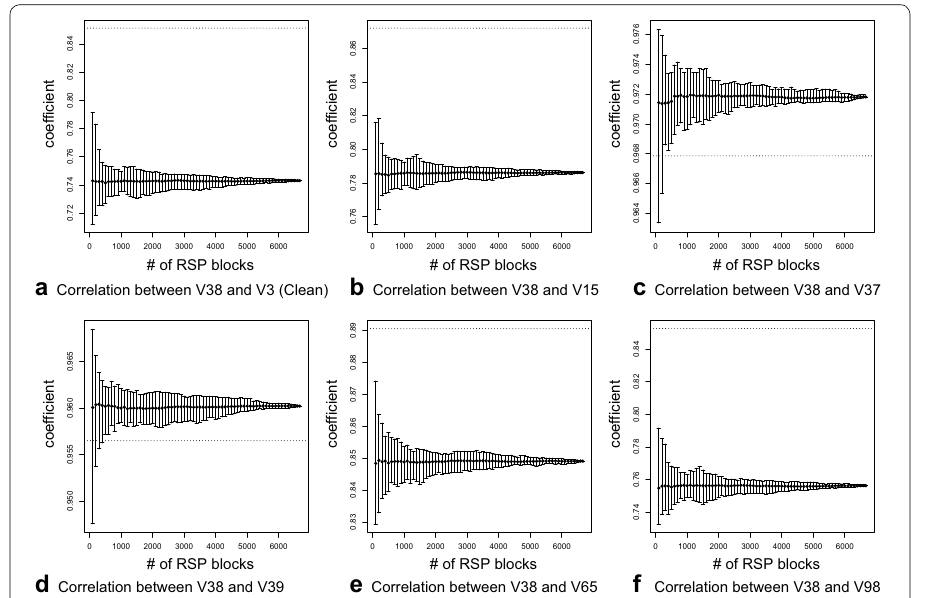
RSP-based coefficients were calculated from a sample of RSP blocks ( g = 100 )